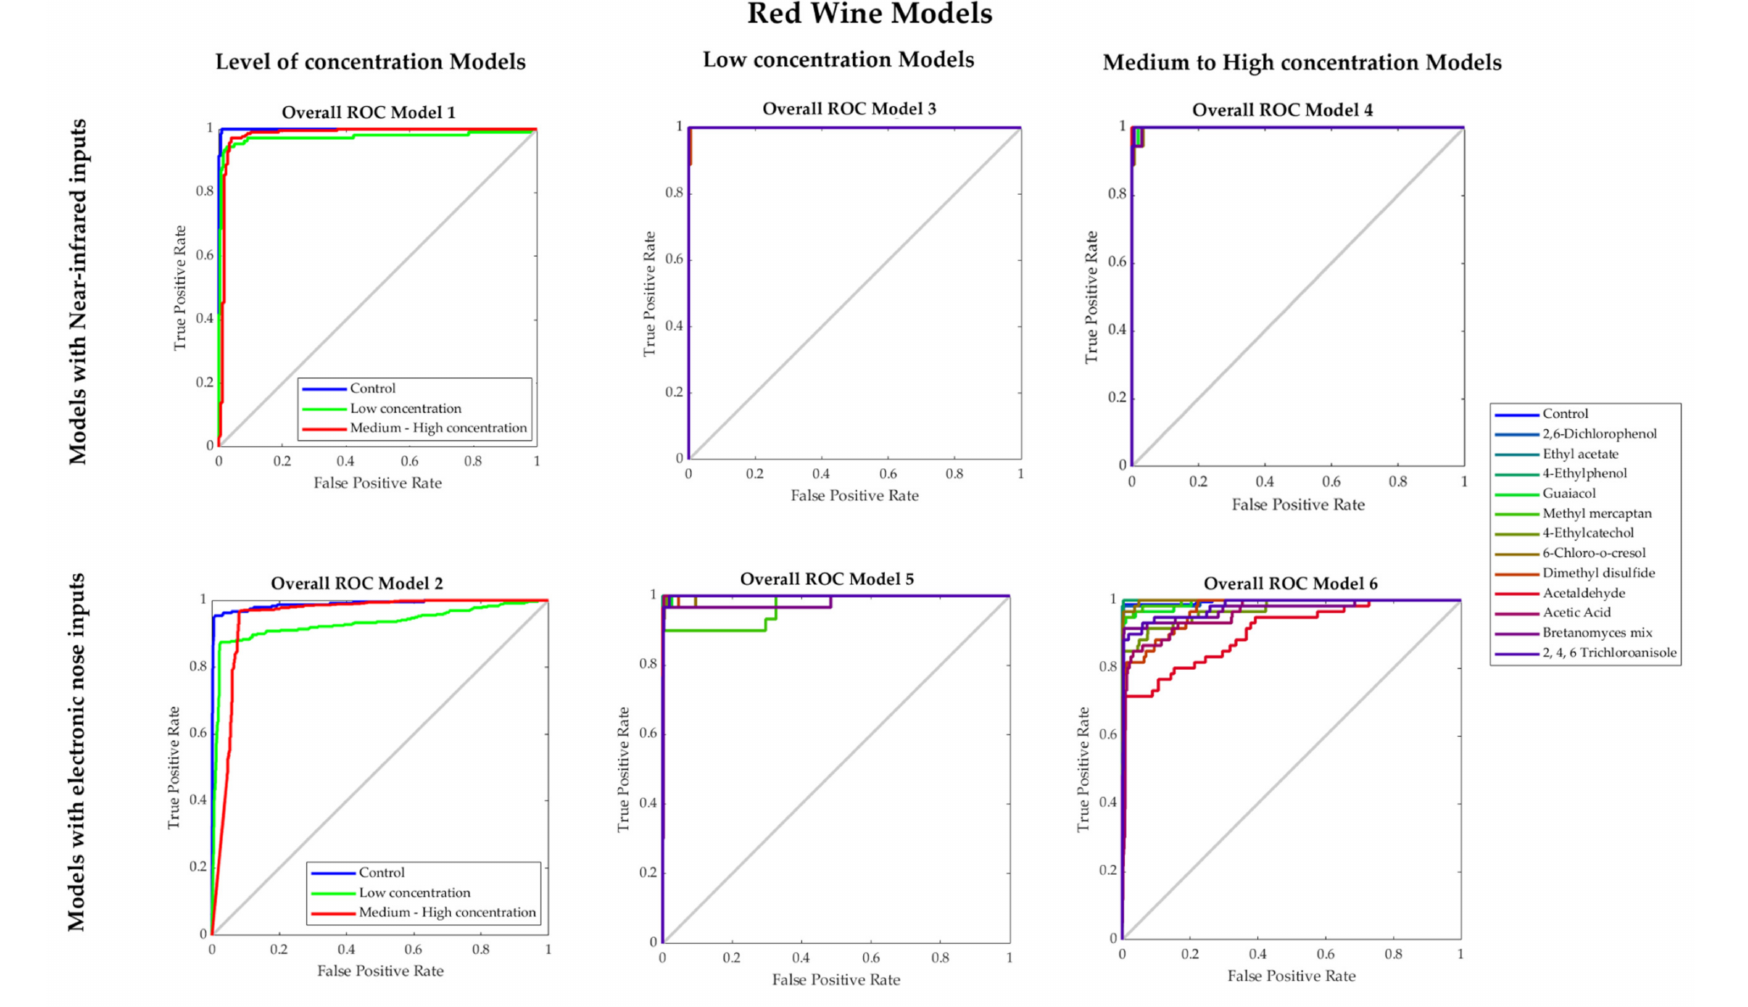
Figure 5. Receiver operating characteristics (ROC) curves of the overall Models 1–6 developed for red